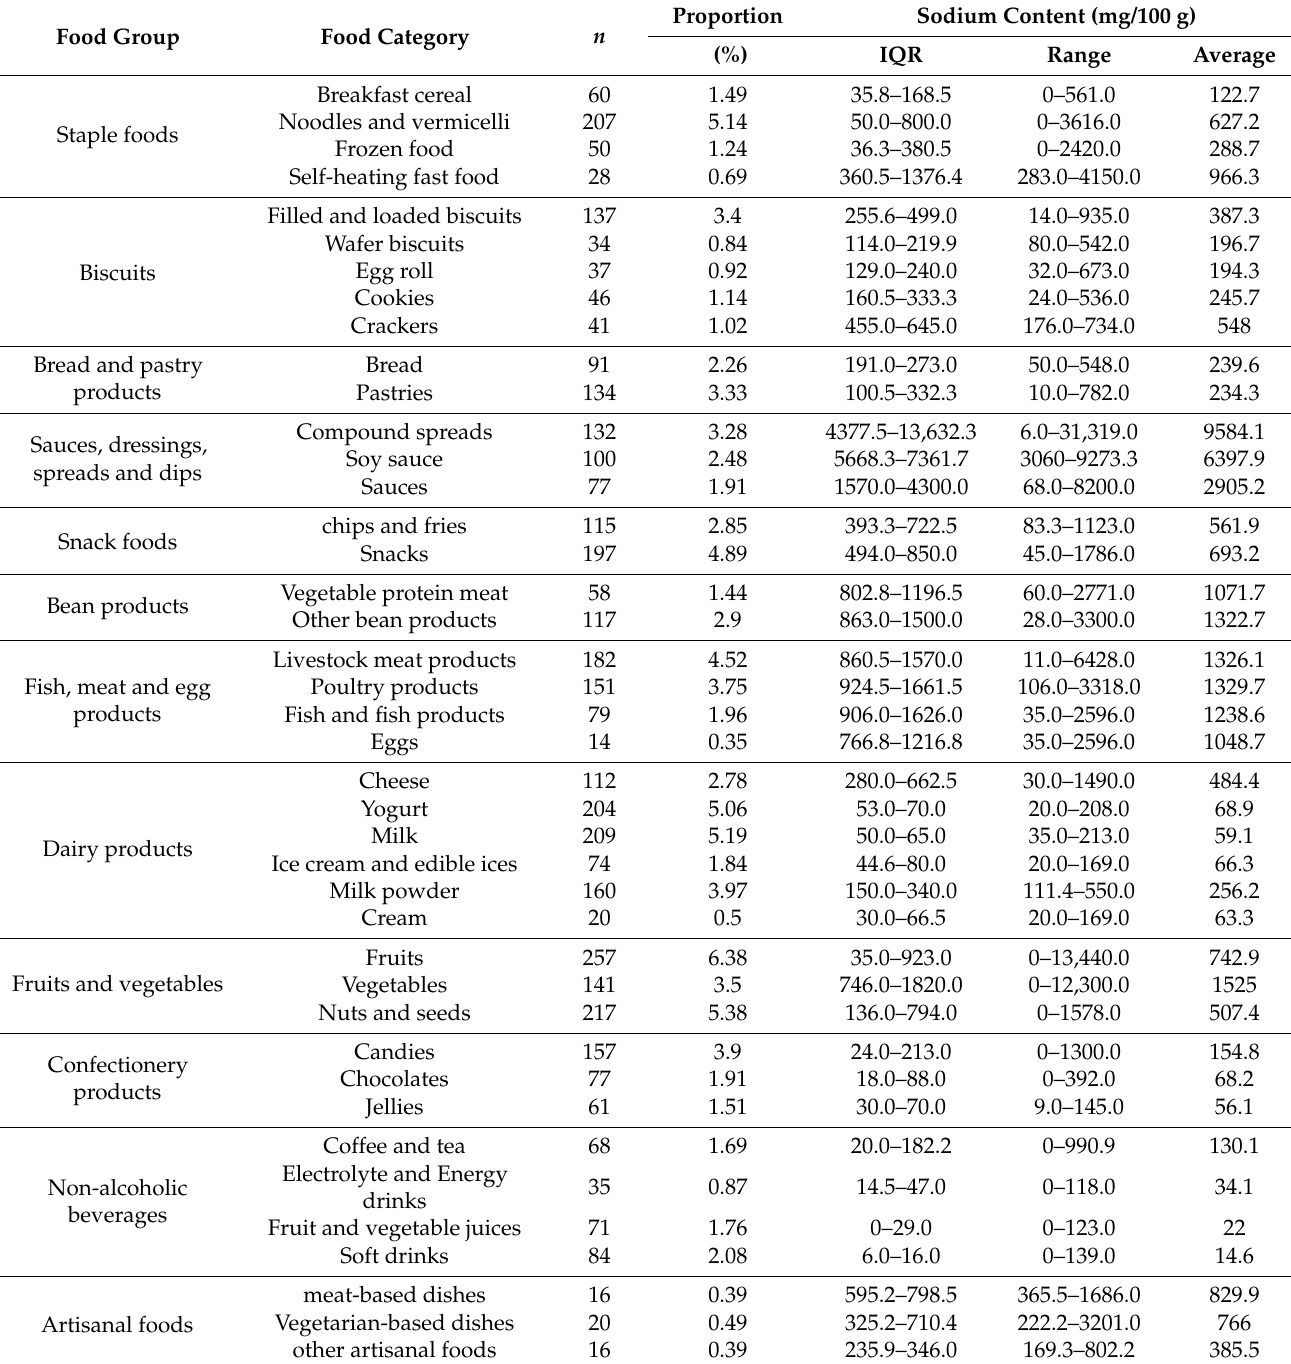
Table 2. The sodium labels and content by category for commercial